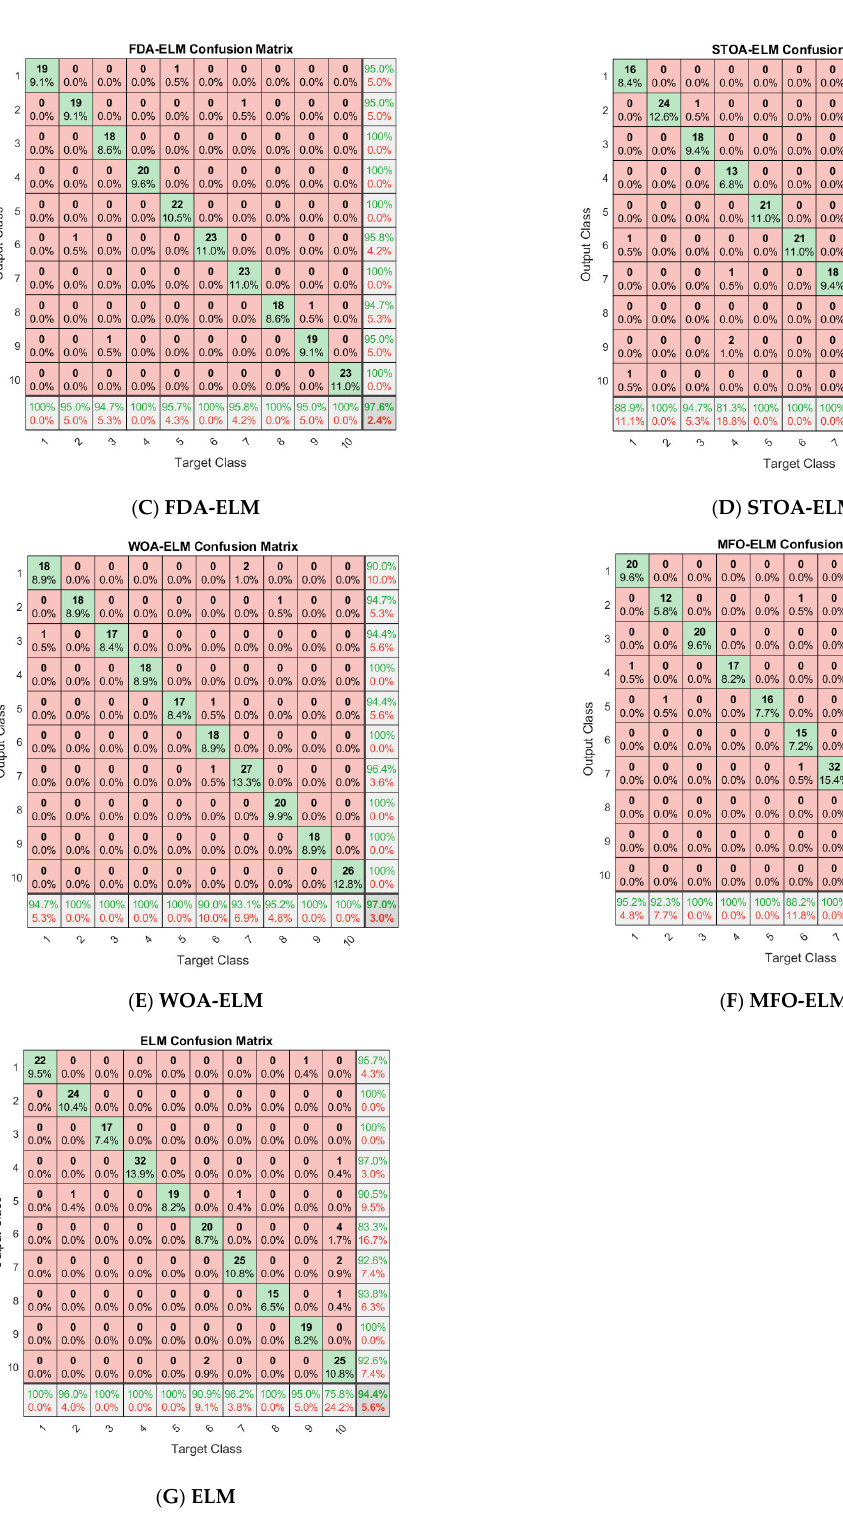
Figure 8. Confusion matrix (Fish4Knowledge) of each algorithm, including DenseNet201 ( A ), FCMFDA-ELM ( B ), FDA-ELM ( C ), STOA-ELM ( D ), WOA-ELM ( E ), MFO-ELM ( F ), and ELM ( G ).